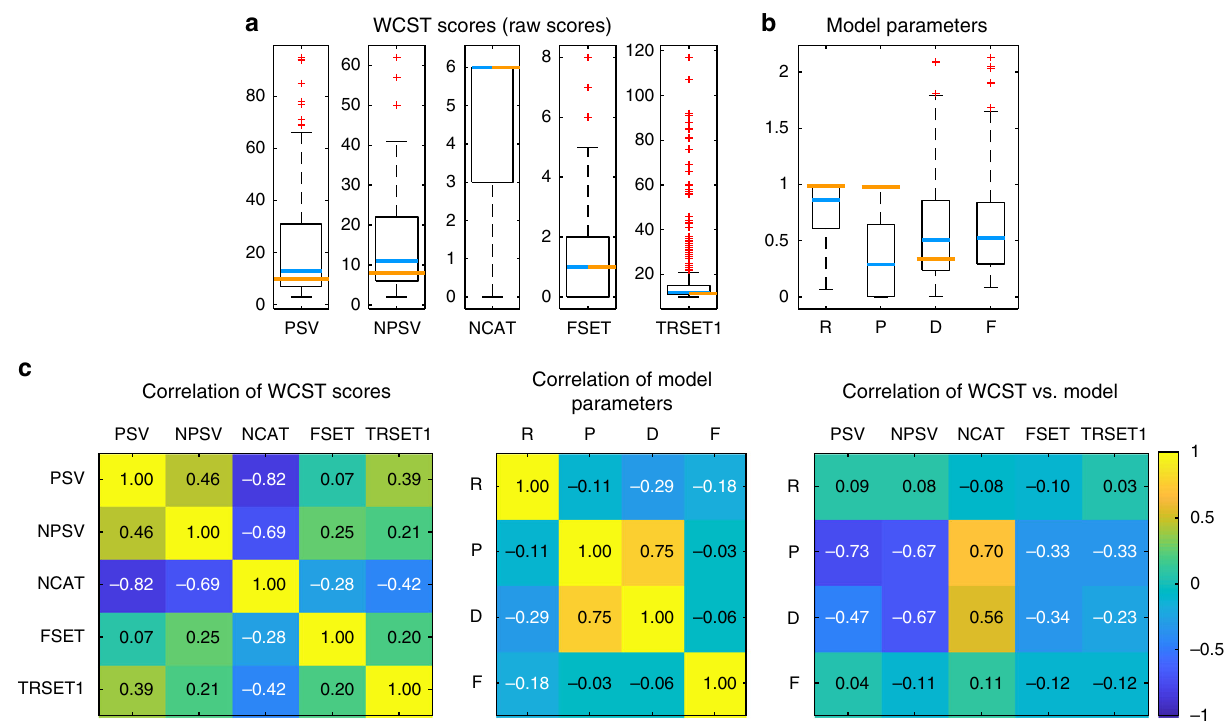
Fig. 2 WCST scores and model parameters from our participant sample. Boxplots of 5 WCST scores ( a ) and 4 model parameters ( b ). PSV perseverative errors, NPSV non-perseverative errors, NCAT number of categories achieved, FSET failure to maintain set, TRSET1 trials to complete fi rst set, R reward sensitivity, P punishment sensitivity, D decision consistency, F attentional focusing. Upper and lower boundaries of the boxes indicated the 75th and 25th percentile, whiskers extend to the most extreme data points not considered an outlier, whereas outliers are plotted as red crosses. Blue lines indicate the median of our sample and orange lines indicate reference points for comparison (in a orange lines represent the median from demographically corrected norms 21 and in b orange lines represent the median from healthy comparison participants reported by Bishara et al. 41 ). The F parameter was fi xed in that study and hence is not reported. c Correlation among and between WCST scores and model parameters